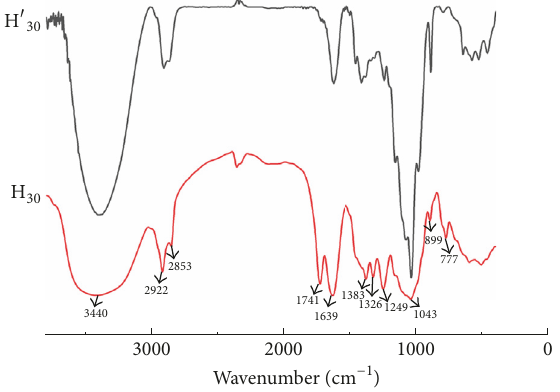
Figure 3: FT-IR spectra of DMSO-extracted fraction H 30 and NaOH-extracted fractions H 󸀠 30 .